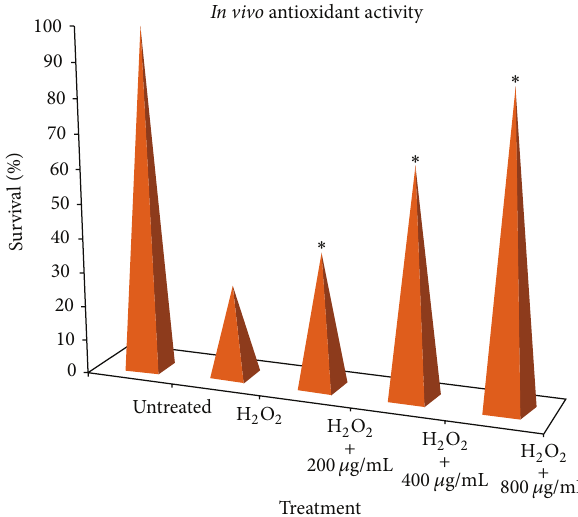
Figure 5: Survival of S. cerevisiae cells untreated and treated with DBPS extract in presence of stressing agent hydrogen peroxide (4mM). ∗ Significantly different from the stressing agents by the analysis of variance (ANOVA) and Dunnett’s 𝑡 -test ( 𝑃 ≤ 0.05